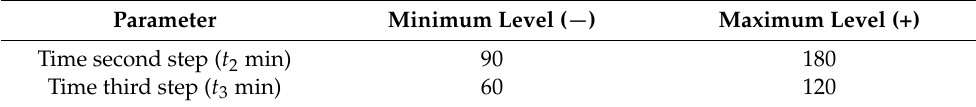
Table 1. Full Factorial Design 2 2 : level definitions for the parameters under investigation.